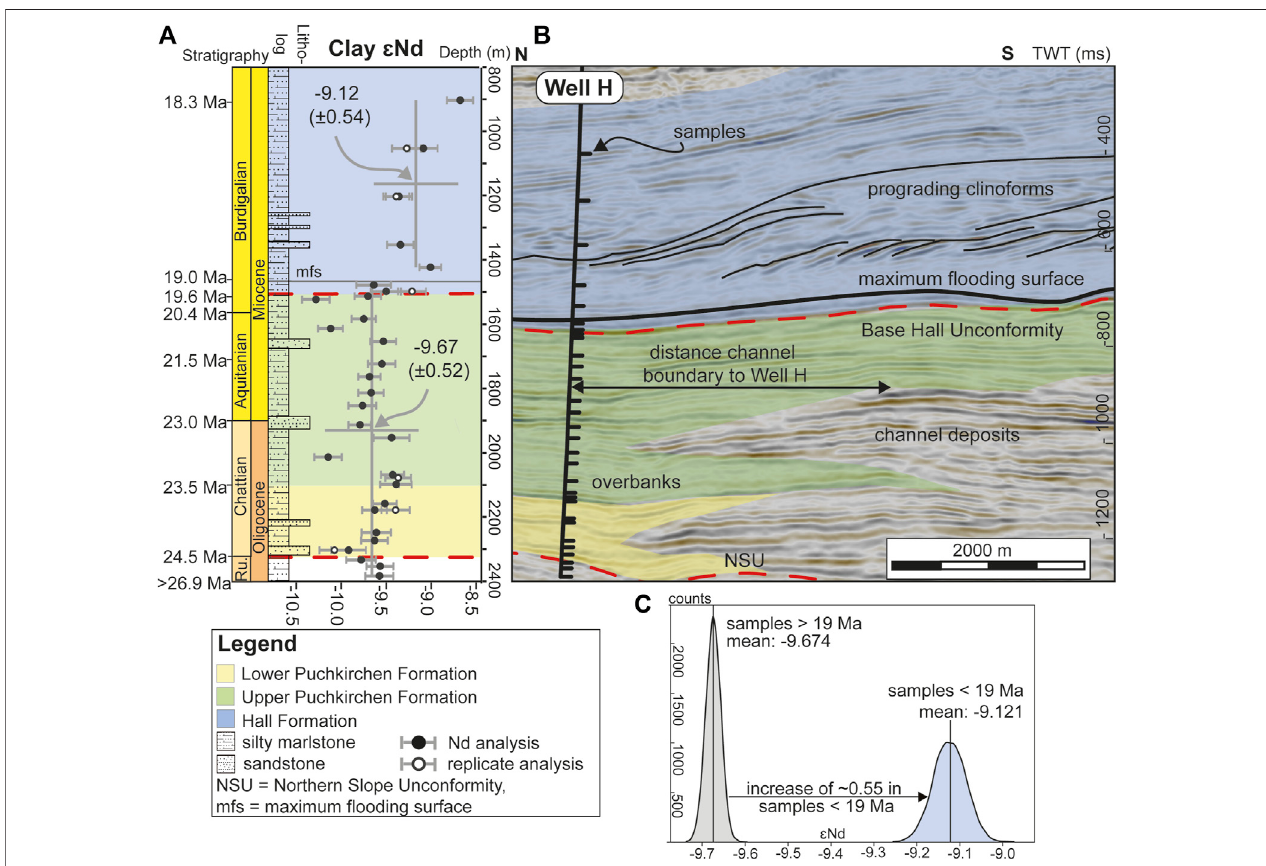
FIGURE 6 | (A) Stratigraphicconcept,lithology(Hülscheretal.,2019)andresultsoftheNdisotopicanalysisofthebulk-rockclay-sizedsedimentfractionfromWellH.Note thesigni fi cantincreaseof ε Ndvaluesabovethemaximum fl oodingsurface(mfs)at19 Ma,afterthecutoffoftheMunichSRS. (B) Interpretedcross-section(N-S)throughtheUpper AustrianNAFBatthelocationofWellH(see Figure2 forposition).SamplesweretakenfromWellHintheZup fi ngFormation,thePuchkirchenGroupandtheHallFormation.Note the change in the depositional environment from an overbank setting in the Puchkirchen Group and basal Hall Formation to a northward prograding prodelta wedge. The verticalresolution (2 m) oftheindividualwell-cuttingsamplesis much higherthan theresolution oftheseismicre fl ection data [~33 m (Masalimovaetal., 2015)]. (C) Resultsofthe Monte-Carloexperiment(10,000runs)ofthetwocalculatedmeangroupsfromthetwo-sampleset( > 19 Ma, < 19 Ma)ofourclay-sized ε Ndresults.Notethesigni fi cantincreaseof the mean of ~0.55 ε Nd units, which supports our interpretation of a change in clay-sized provenance at 19 Ma. See text for discussion.